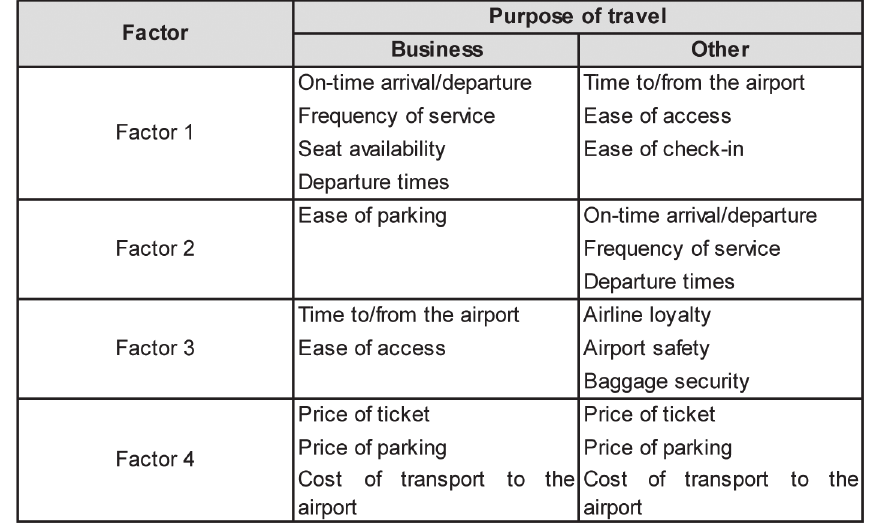
Table 12: Decision factors by purpose of